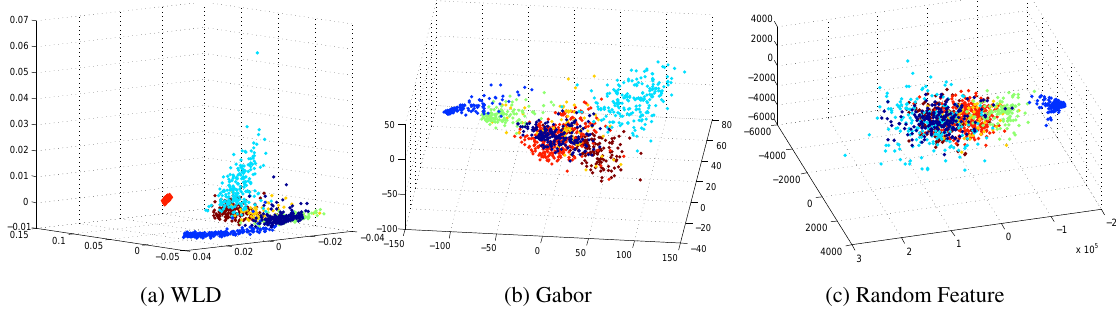
Figure 2: 3D visualization of feature space for three kinds of feature descriptors (e.g., WLD, Gabor, Rand Feat) including the prior annotation of the data. Different colors represent different prior clusters (e.g.,forest, water, medium density urban area, forest + water, roads, high density urban area, and urban area + roads).